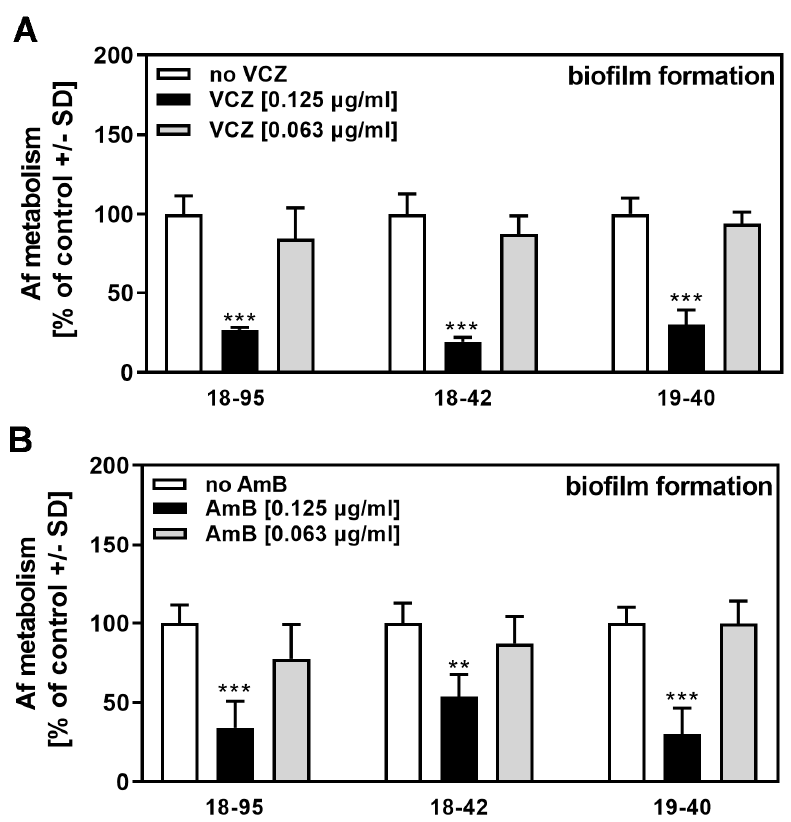
Figure 5. AfuPmV-1 infection does not sensitize A. fumigatus to VCZ or AmB. Infected (18–95, 19–40) or virus-free (18–42) Aspergillus forming biofilm was incubated with ( A ) VCZ (0.063 or 0.125 µg/mL), or ( B ) AmB (0.063 or 0.125 µg/mL) at 37 °C for 16 h. Fungal metabolism was measured by XTT assay. Metabolism in the presence of RPMI alone (white bars for each strain) was regarded as 100%. Comparisons: No drug (white bars) vs. drug (black and grey bars) for each strain. Statistical analysis (n = 4): Unpaired t -test. Two or three asterisks = p ≤ 0.01 or p ≤ 0.001, respectively. No significant differences in drug response were observed when comparing infected strains (18–95 and 19–40) to the virus-free strain (18–42).